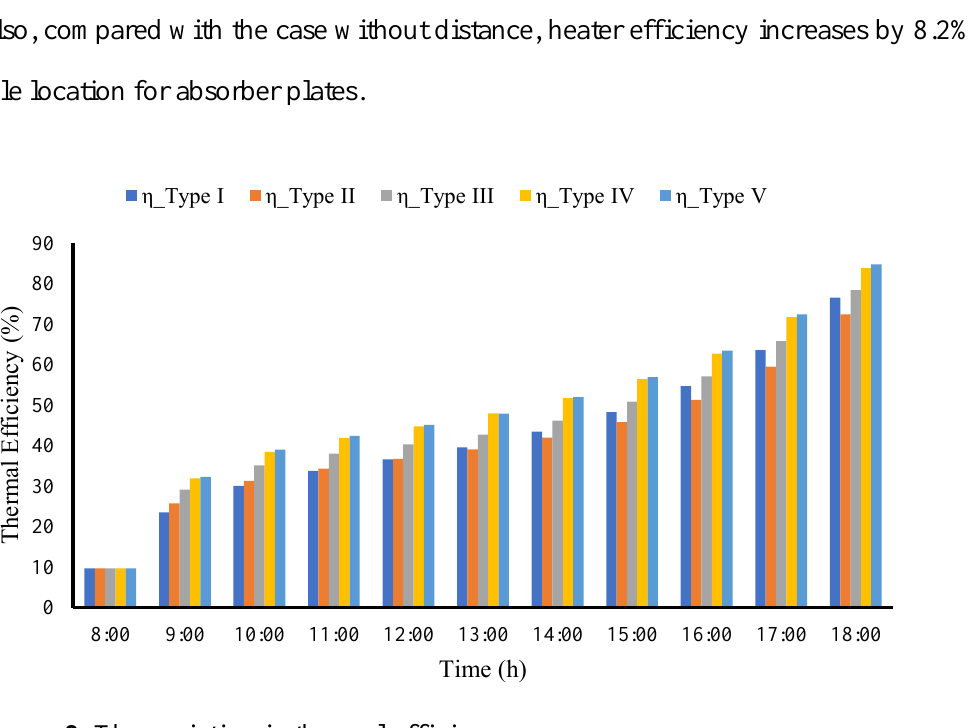
Figure 8. The variation in thermal